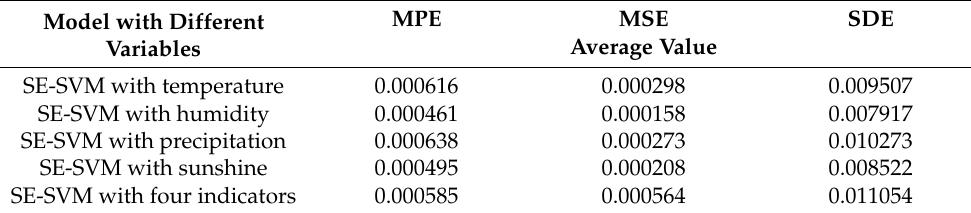
Table 2. Forecasting the VTH using different model settings.